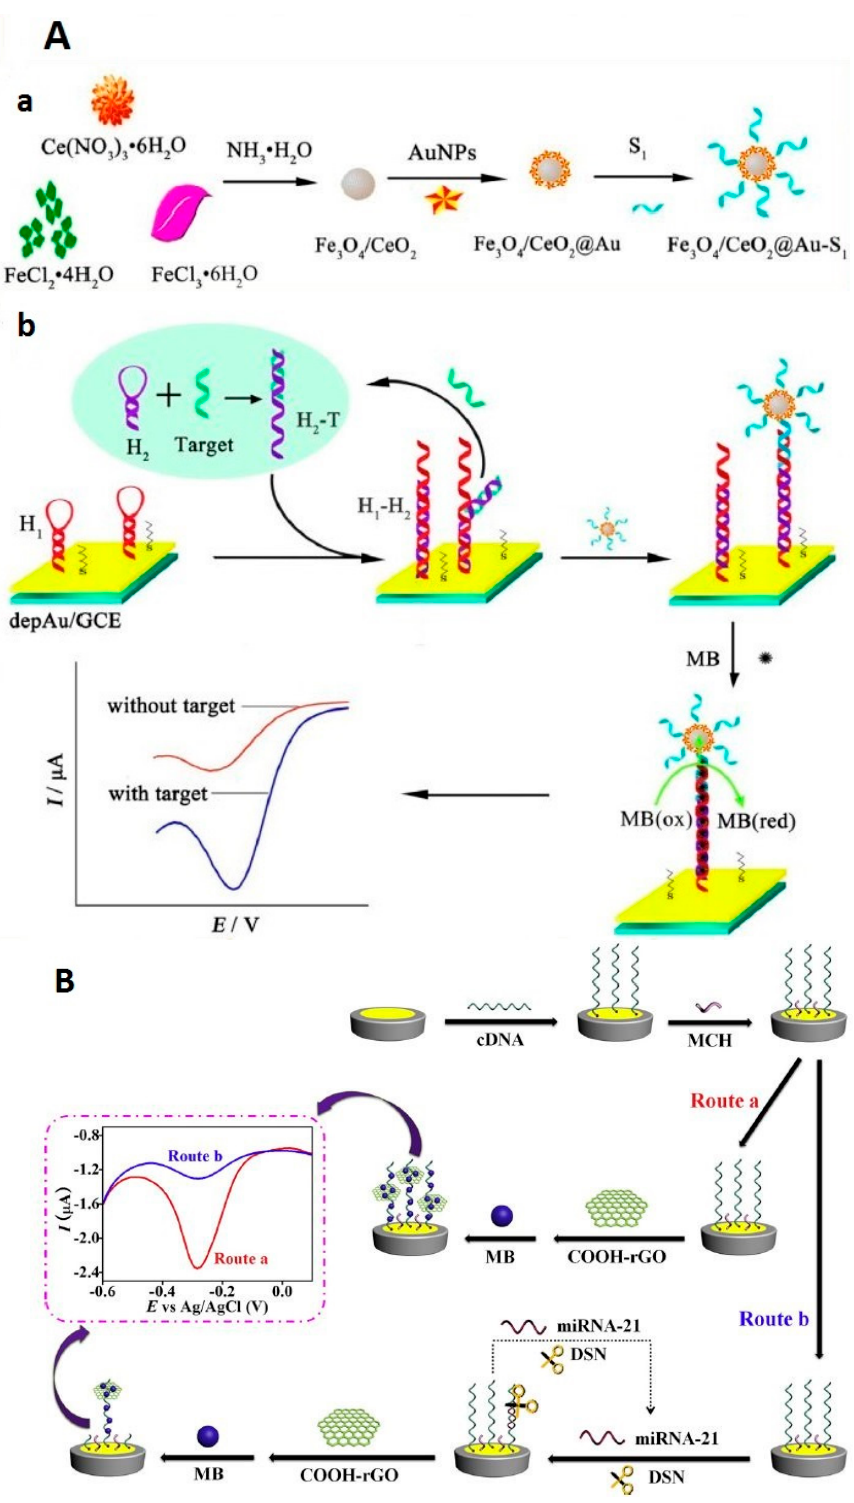
Figure 13. Example of biosensors using amplification strategy with nanomaterials as a non-nanocatalyst; ( A ) the nanomaterials are formed with Fe 3 O 4 and cerium dioxide (CeO 2 ) decorated with gold nanoparticles (Fe 3 O 4 / CeO 2 @AuNPs) reproduced from. ( a ) Preparation procedure of Fe 3 O 4 / CeO 2 @Au-S 1 , ( b ) signal amplification strategy and the detection principle for microRNA [146] with permission of the publisher; ( B ) biosensors using graphene oxide and DSN as amplification method from [147] reproduced with permission of the publisher.